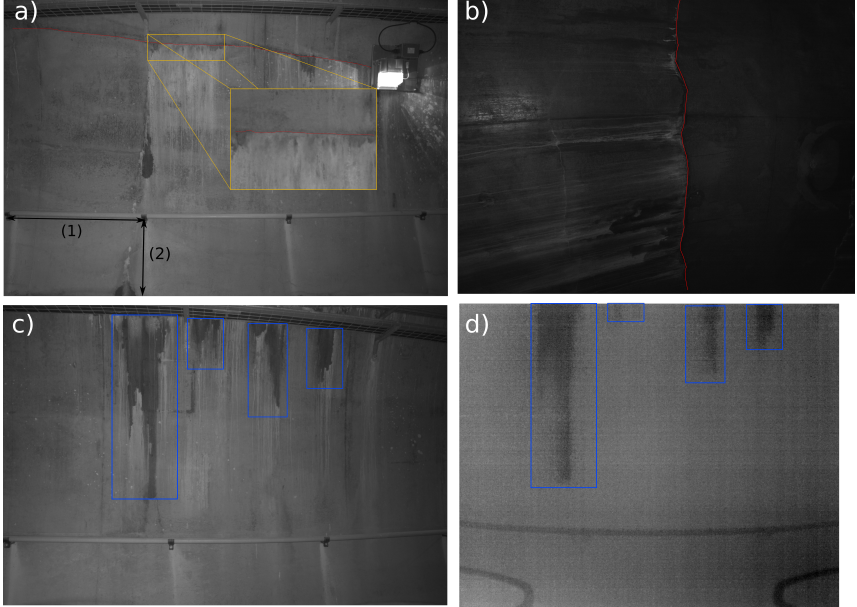
Figure 13. ( a ) Thin concrete crack visible on the tunnel wall marked in red. ( b ) Long ceiling concrete crack. ( c ) Water inlet areas marked in blue on the visual image. ( d ) Water inlet areas identified on the thermal